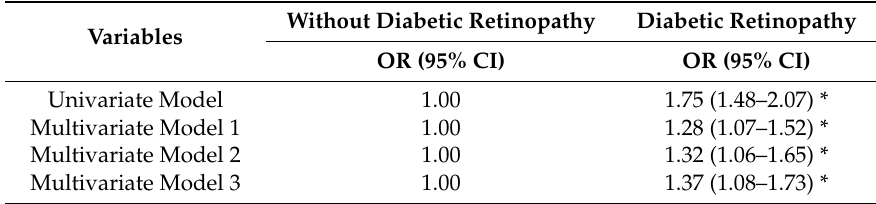
Table 2. The association between diabetic retinopathy and risk of CKD progression. Variables